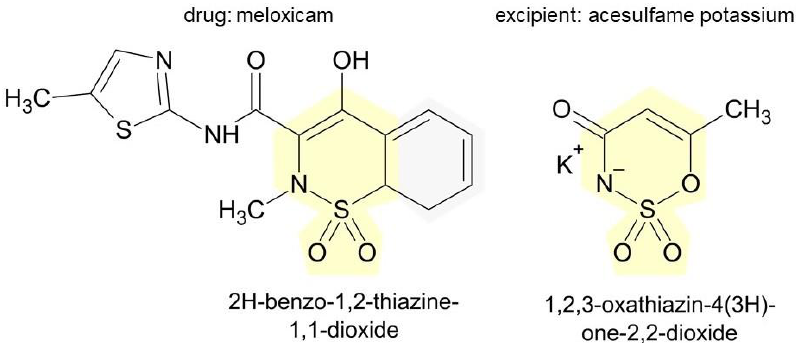
Figure 3. Comparison of the chemical formulas of MEL and its excipient acesulfame potassium, which share similar structures (in yellow). Sketches were created with ACD/ChemSketch software, 1 February 2018.2.1.